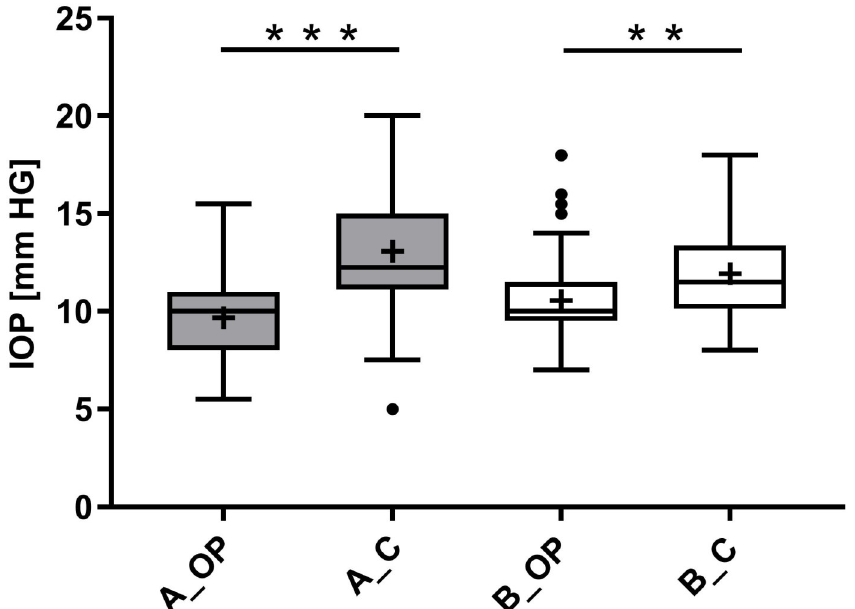
Fig 5. IOP in the operated (OP) and control eye (C) in animal groups A and B. The performed paired t-test, considering the IOP measurements over the entire observation period, shows a highly statistically significant IOP difference between both eyes for prototype A (p < 0.0001) in contrast to prototype B with a moderately statistically significance (p = 0.0063). ( � = p � 0.05, �� = p � 0.01, ��� = p � 0.001, n = 68, + = mean, ─ = median, ● = outlier, A = prototype A, B = prototype B, OP = IOP of the operated eye, C = IOP of the control eye).